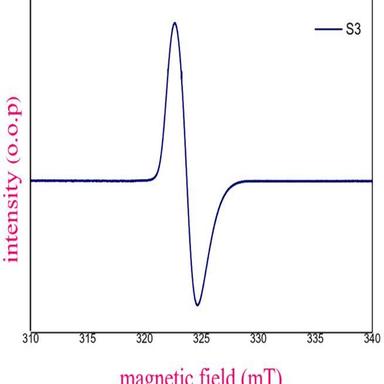
X-band ESR spectrum of the novel double-decker lutetium(III) bisphthalocyanine.